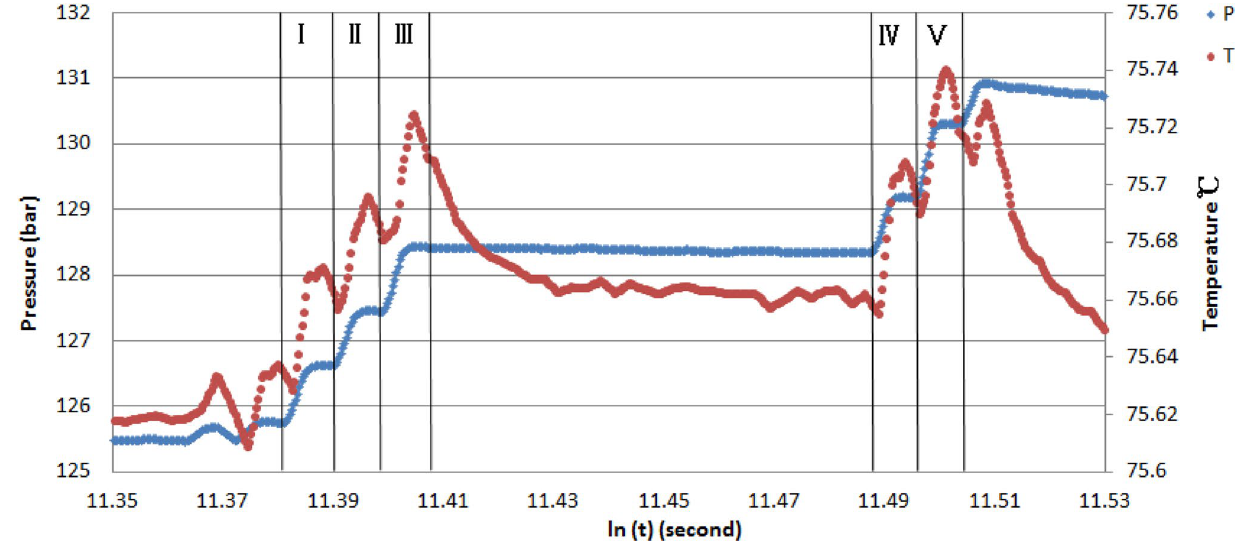
Fig. 15 Denoised pressure and temperature data of Case 2